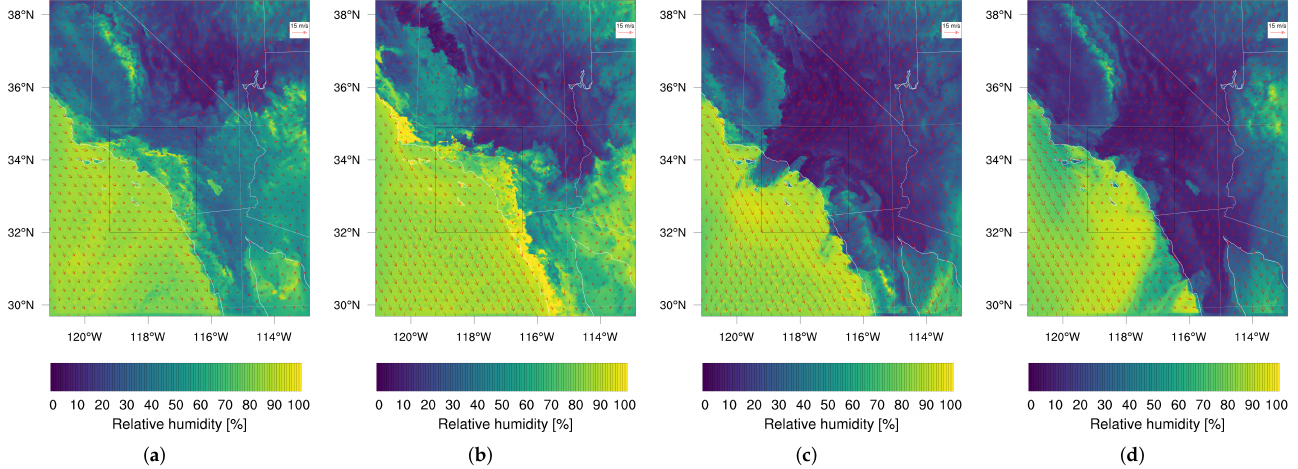
Figure 3. Modeled 10 m wind speed and relative humidity for 14 October, 2 p.m. ( a ), 15 October,